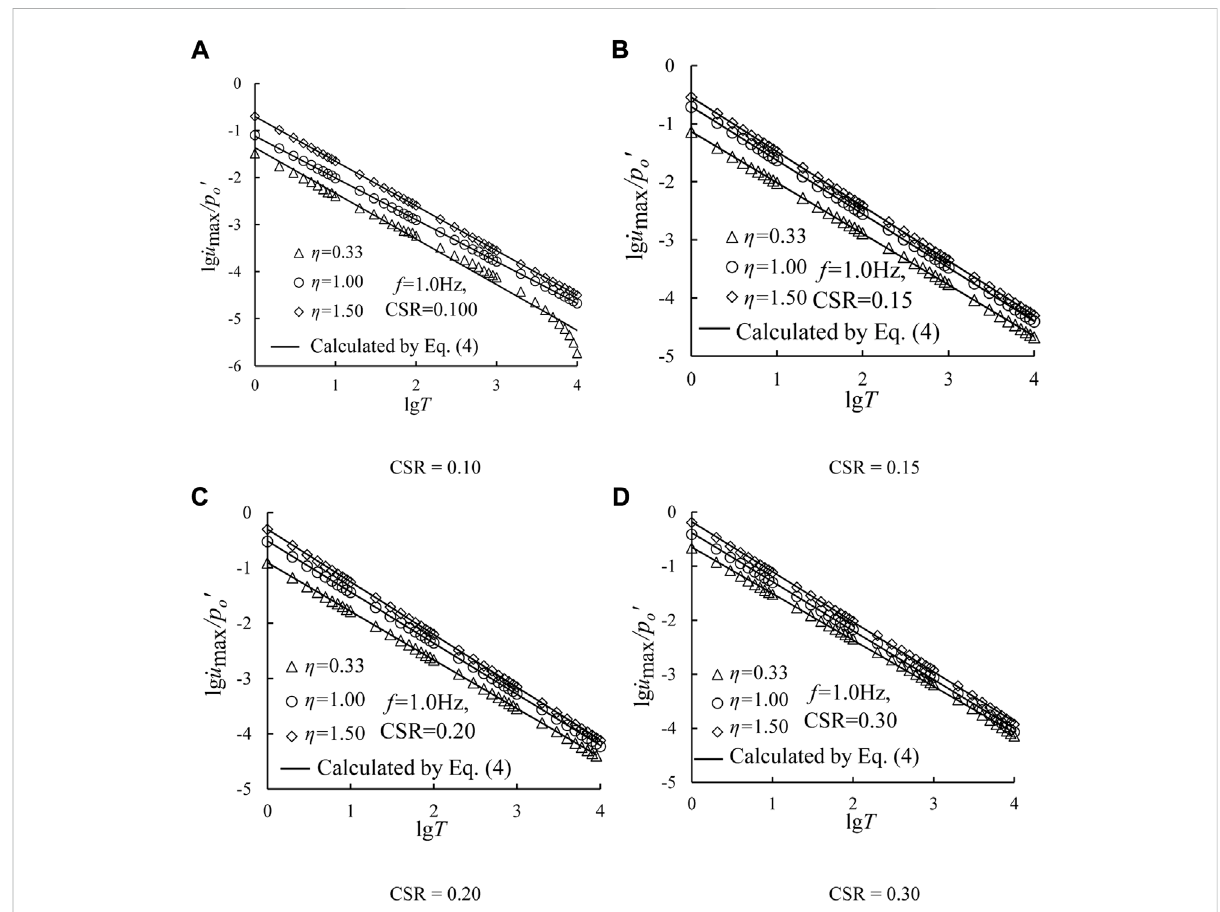
FIGURE 10 Relationshipsbetweenlg _ u max / p ′ o versuslg T underdifferent η valuesfor f =1.0 Hz. (A) CSR=0.10; (B) CSR=0.15; (C) CSR=0.20; (D) CSR=0.30.